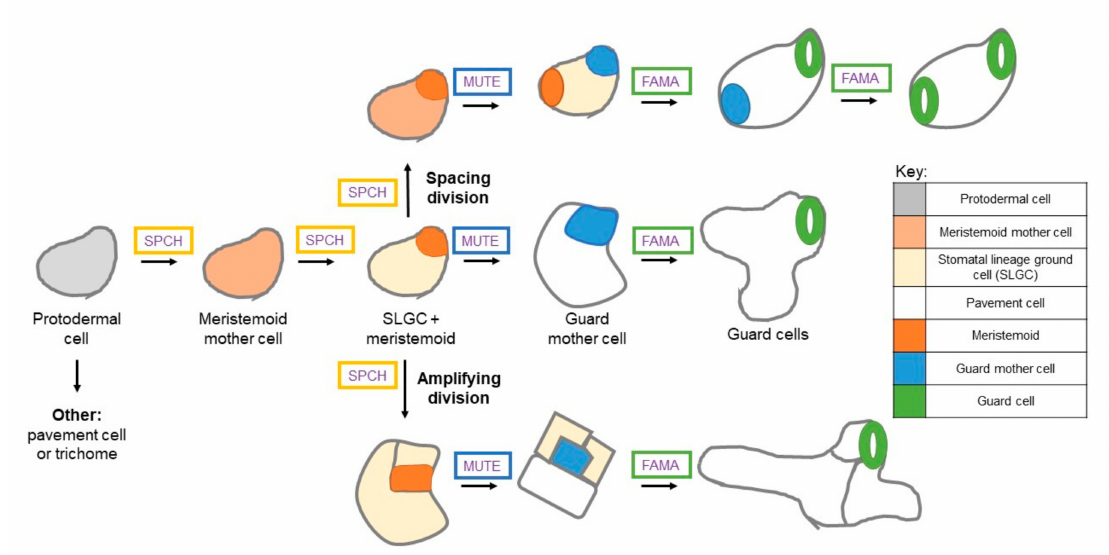
Figure 1. Cells of the stomatal lineage. A protodermal cell (grey) enters the stomatal lineage when it becomes a meristemoid mother cell (MMC). A symmetric division of the MMC produces a meristemoid (orange) and a stomatal lineage ground cell (SLGC). Meristemoids undergo self-renewing amplifying divisions or develop into a guard mother cell (blue). This guard mother cell (GMC) symmetrically splits once to shape a pair of guard cells (green). SLGCs can develop into pavement cells (white) or they can be subjected to a spacing division to create a new meristemoid (orange). The basic-helix-loop-helix (bHLH) master transcription factors SPEECHLESS (SPCH), MUTE and FAMA, critical for the development of stomata, are displayed in the